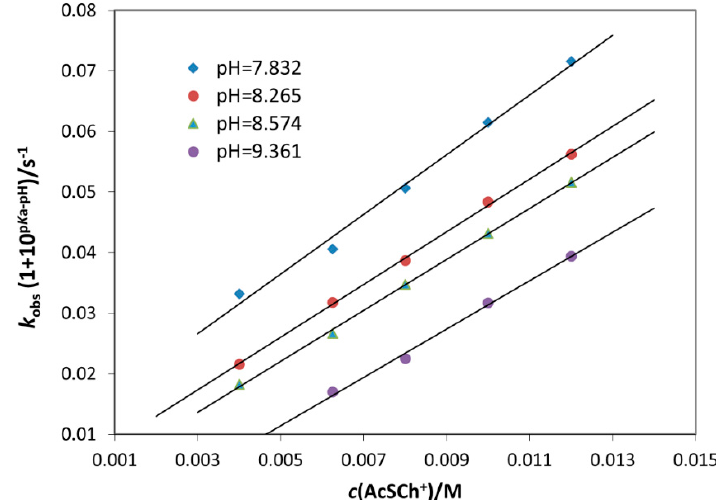
Figure 1. Observed rate constants for oximolysis of AcSCh + by BPA4 at different pH of the medium, I = 0.1 M and 25 °C.